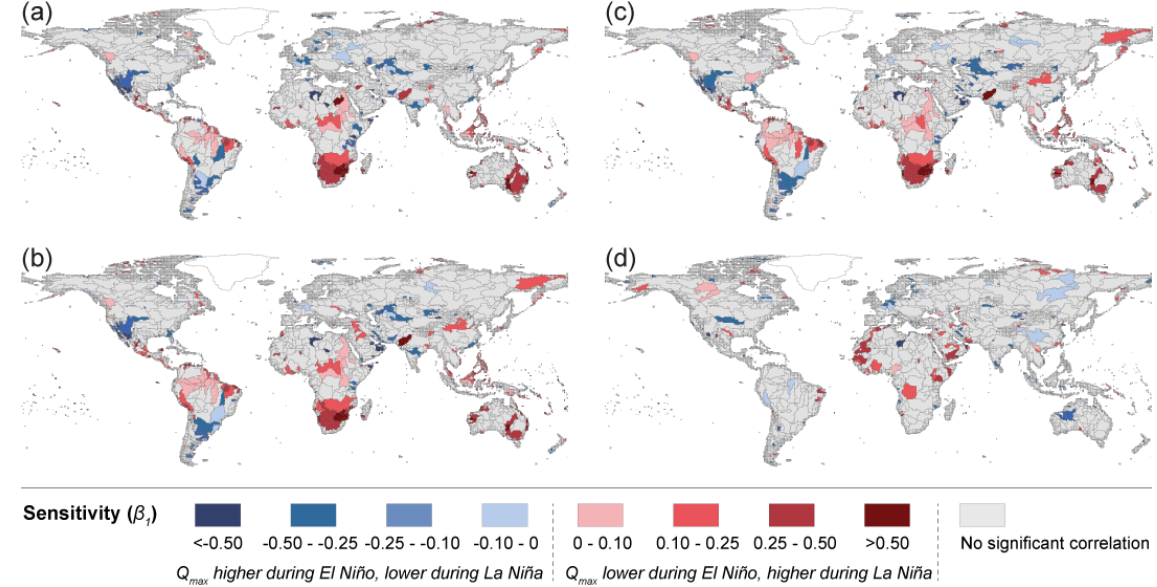
Fig. A2. Sensitivity ( β 1) of ln Q max to variations in SOI for basins with significant correlation (Pearson’s r , t statistic, α = 0 . 10). The sensitivity is shown for hydrological year Q max to 3-month mean SOI for (a) October-November-December (OND); (b) November-December-January (NDJ); (c) December-January-February (DJF); and (d) January-February-March (JFM). Negative correlation generally represents higher annual floods in El Niño years/lower annual floods in La Niña years, while positive correlation generally represents the